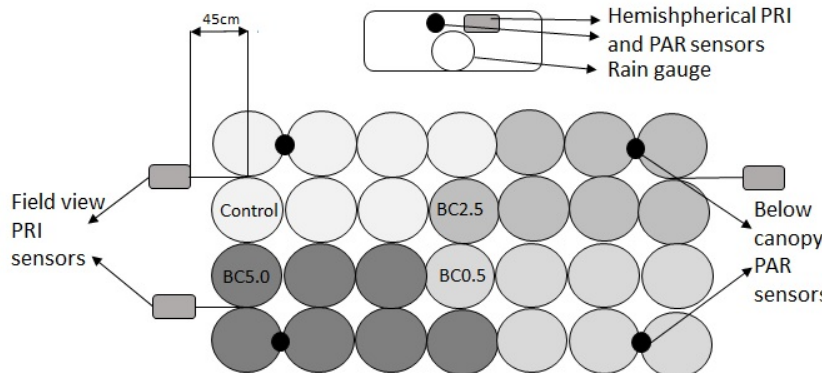
Figure 1. Schematics of the experimental setup at the beginning of the experiment. photochemical reflectance index (PRI) is the photochemical reflectance index and photosynthetically active radiation (PAR) is the photosynthetically active radiation.